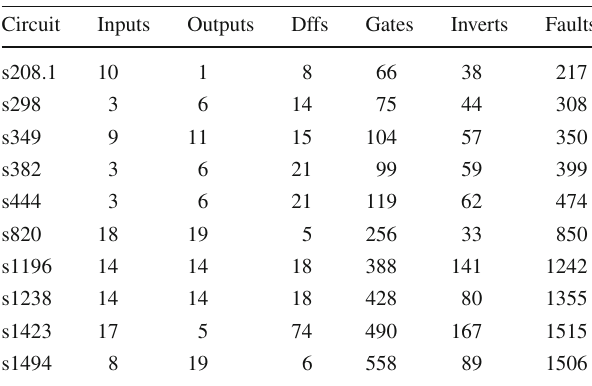
Fig. 10 Evolution in genetic algorithm Table 1 ISCAS’89 subset